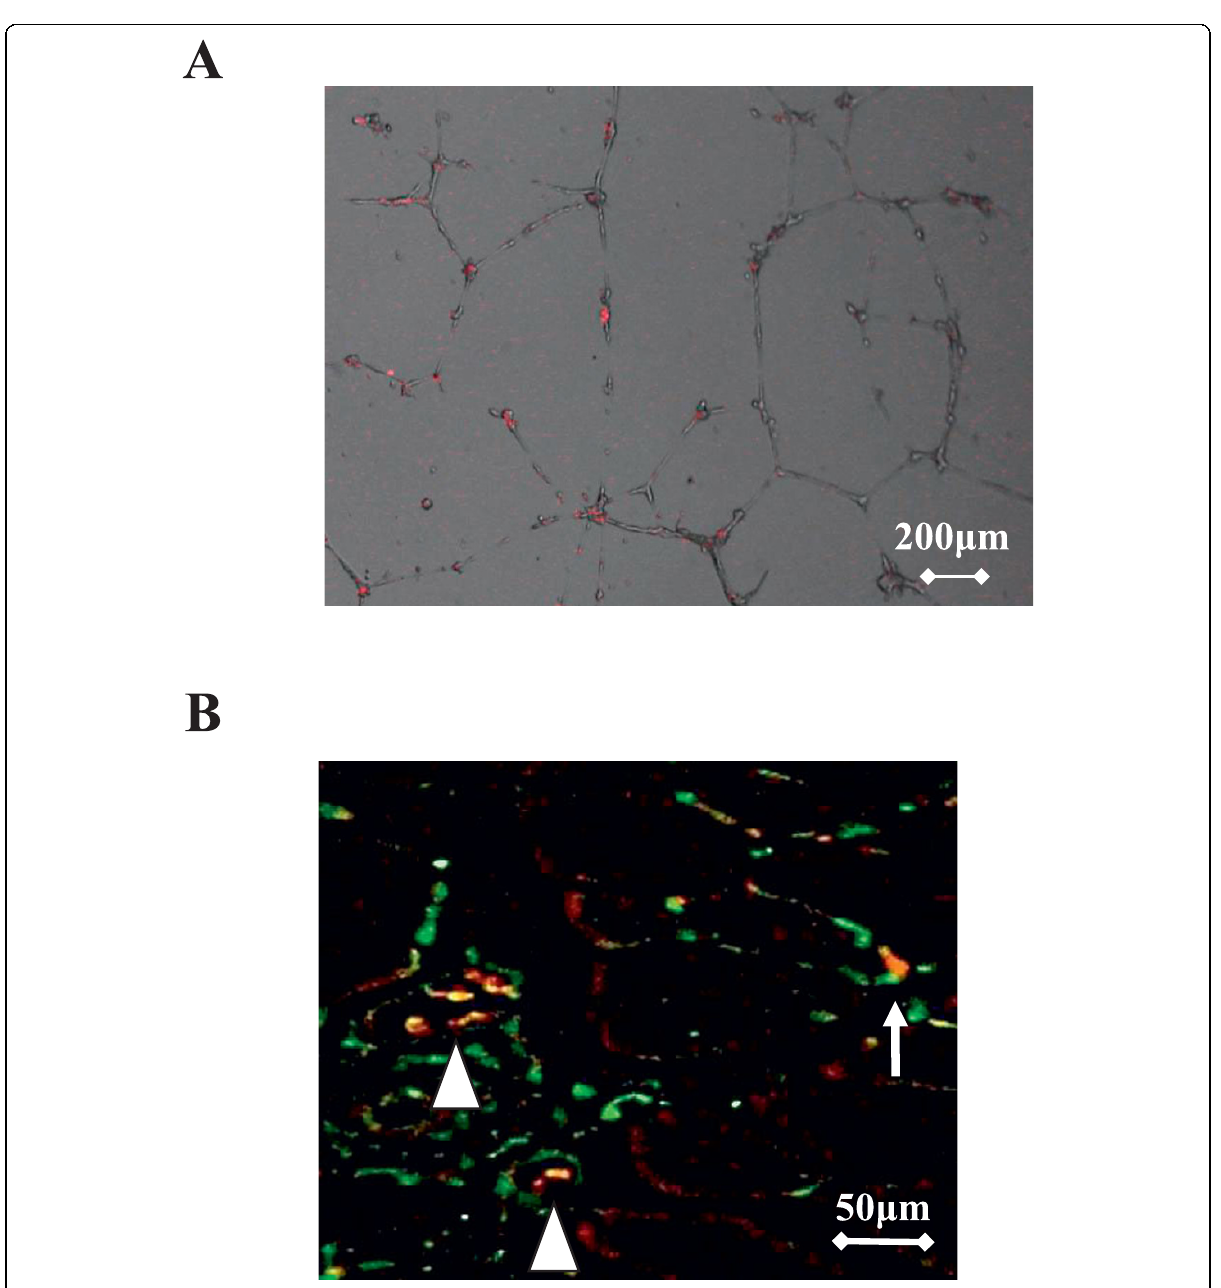
Figure 6 Tracking Flk-1 + cells in vitro and at chronic phase in vivo . A) Tube formation assay in vitro. PKH26 red-labeled Flk-1 + iPS cells were co-cultured with HUVECs for 24 hours on Matrigel. iPS cells (red) were confirmed to be incorporated into network structures. The bar indicates 200 μ m. B) Double fluorescence staining of CD31 (green) and PKH26 (red) in ischemic adductor muscles on postoperative day 21. Co-localization is indicated by yellow in the merged images (magnification, ×400; bar indicates 50 μ m). Flk-1 + cells (6 × 10 4 cells) were stained with PKH26 red and then injected into ischemic adductor muscles. Double positive cells ( ▲ ) and single positive PKH26 cells( ↑ ) are